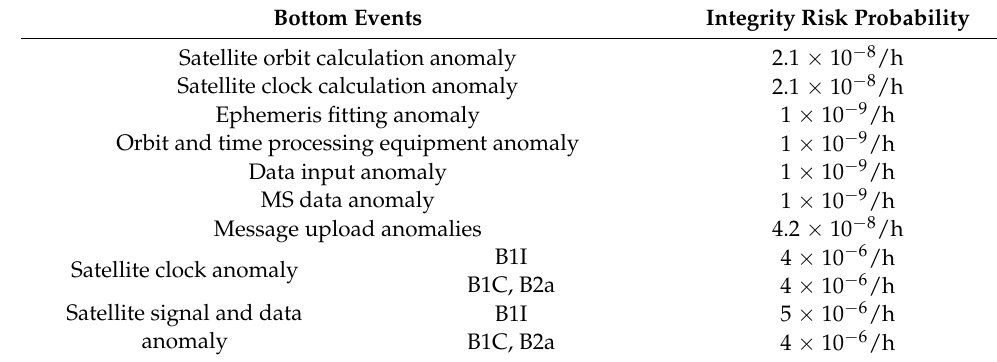
Table 5. Integrity risk of BDS SIS bottom